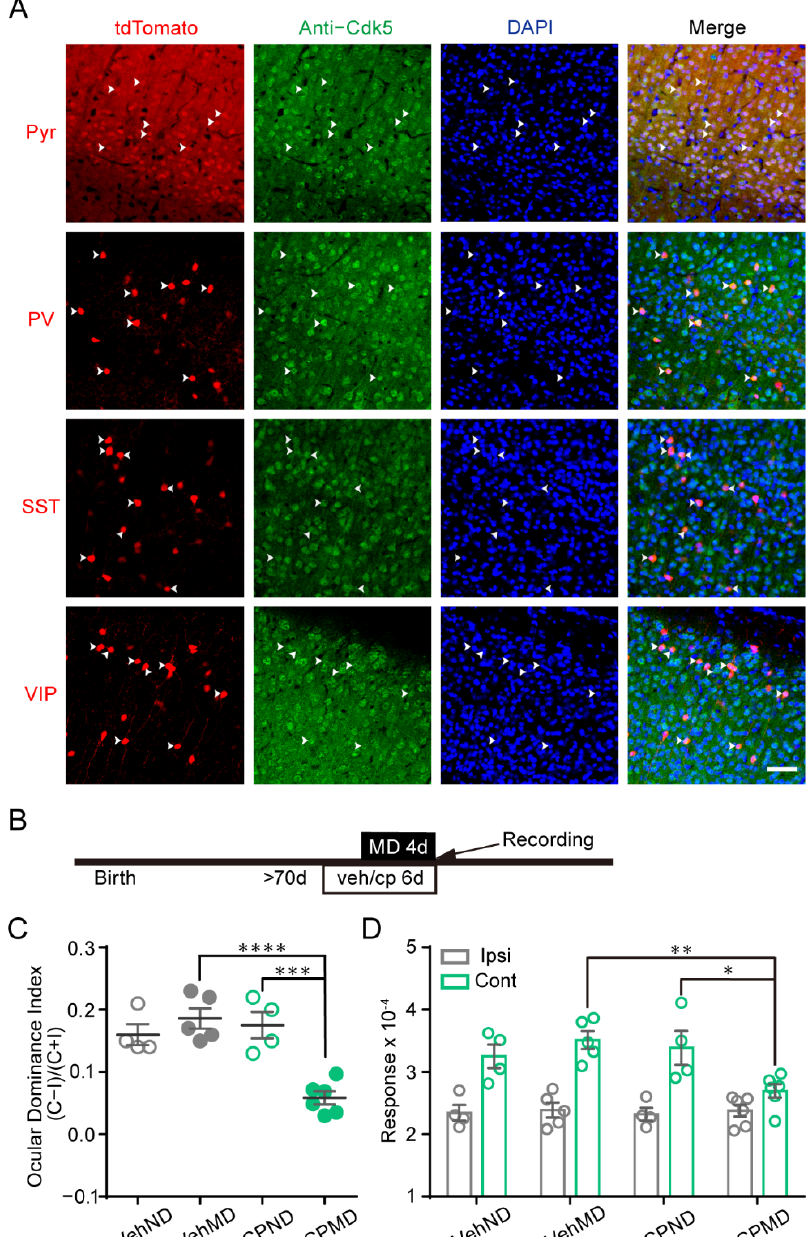
Figure 1. The distribution of Cdk5 in subtype neurons of mouse V1, and the reactivation of OD plasticity by pharmacological inhibition of Cdk5. ( A ) Representative images of the co-localization of tdTomato-expressing neurons (pyramidal (Pyr), parvalbumin (PV), somatostatin (SST) or vasoactive intestinal polypeptide (VIP) neurons) (red) with Cdk5-positive cells (green) in V1. Arrows indicate the co-localized neurons of tdTomato expression and molecular markers. Scale bar, 50 μ m. ( B ) Experimental design. ( C ) Comparison of ODI measured from vehicle-treated mice with/without MD (gray) and CP681301-treated mice with/without MD (green) (F(1, 15) = 12.66; CPMD versus CPND, p < 0.001; CPMD versus VehMD, p < 0.0001; two-way ANOVA with Tukey’s post hoc test). ( D ) Comparison of response magnitude of intrinsic optical signals elicited by stimulating the ipsilateral eye or contralateral eye (F(3, 30) = 3.51; cont: CPMD versus CPND, p < 0.05; CPMD versus VehMD, p < 0.01; two-way ANOVA with Tukey’s post hoc test). Veh: vehicle; CP: CP681301; ODI: ocular dominance index; MD: monocular deprivation; ipsi: ipsilateral eye; cont: contralateral eye. Data shown as mean ± SEM. * p < 0.05, ** p < 0.01, *** p < 0.001, **** p < 0.0001.